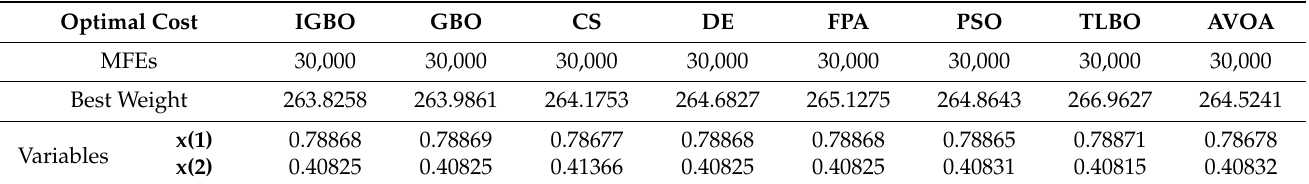
Table 9. Comparison of best solutions for the three-bar truss design.